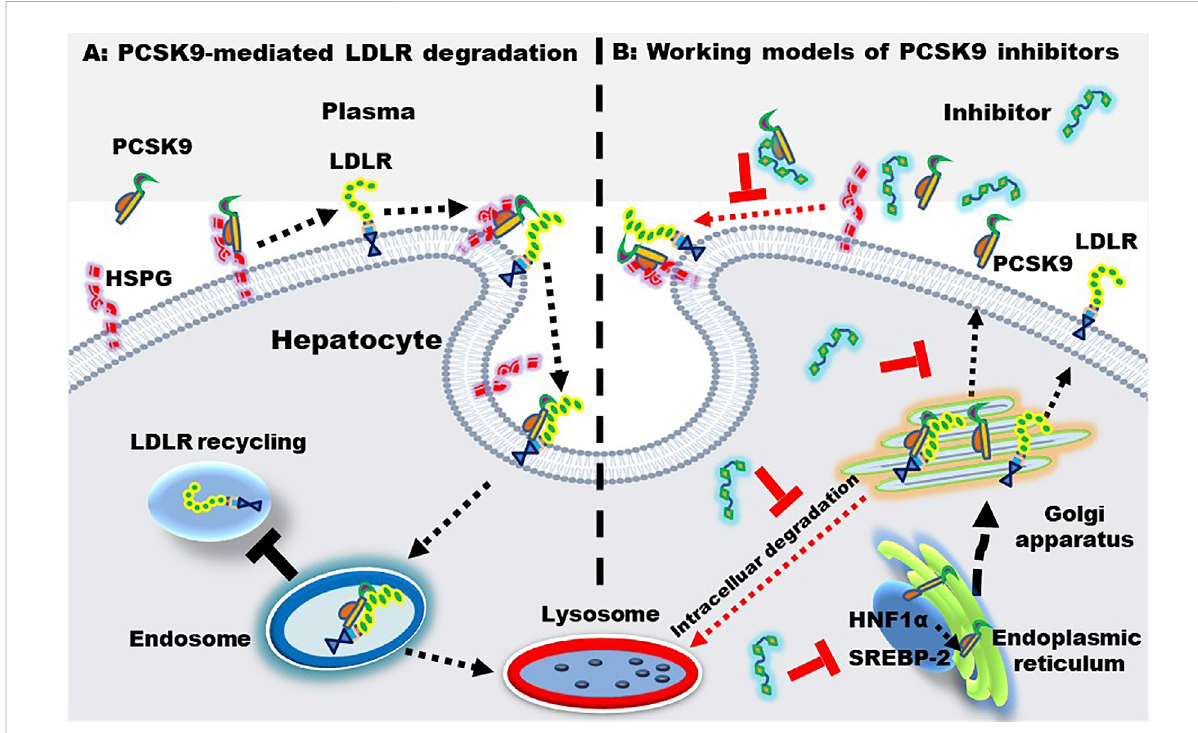
FIGURE 4 PCSK9-mediated LDLR degradation and the working models of PCSK9 inhibitors. (A) PCSK9-mediated LDLR degradation. Heparan sulfate proteoglycan (HSPG) located at the hepatic surface captures PCSK9, enhancing the binding between PCSK9 and LDLR. Upon binding, the PCSK9- LDLRcomplexisinternalized and transferredto endosome,where PCSK9 bindsLDLR withan evenhigheraf fi nity.Finally,thecomplexistransported to the lysosome for degradation. (B) working models of PCSK9 inhibitors. PCSK9 inhibitors may inhibit PCSK9-LDLR interactions, PCSK9 production,transcription,andsecretion. ThePCSK9expressionisregulatedbysterolregulatorybindingprotein-2(SREBP-2)andhepatocyte nuclear factor 1 α (HNF-1 α